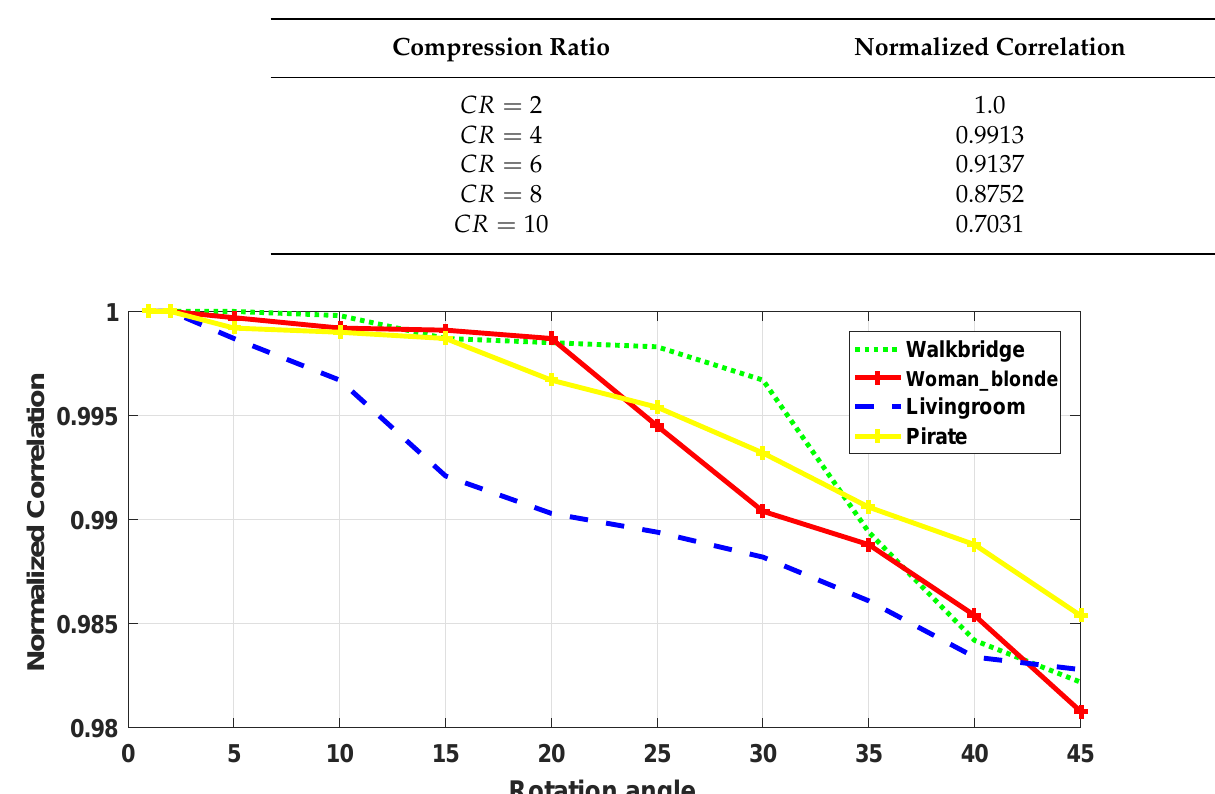
Table 7. Watermark robustness against JPEG2000 attack in terms of NC for 30 test images.